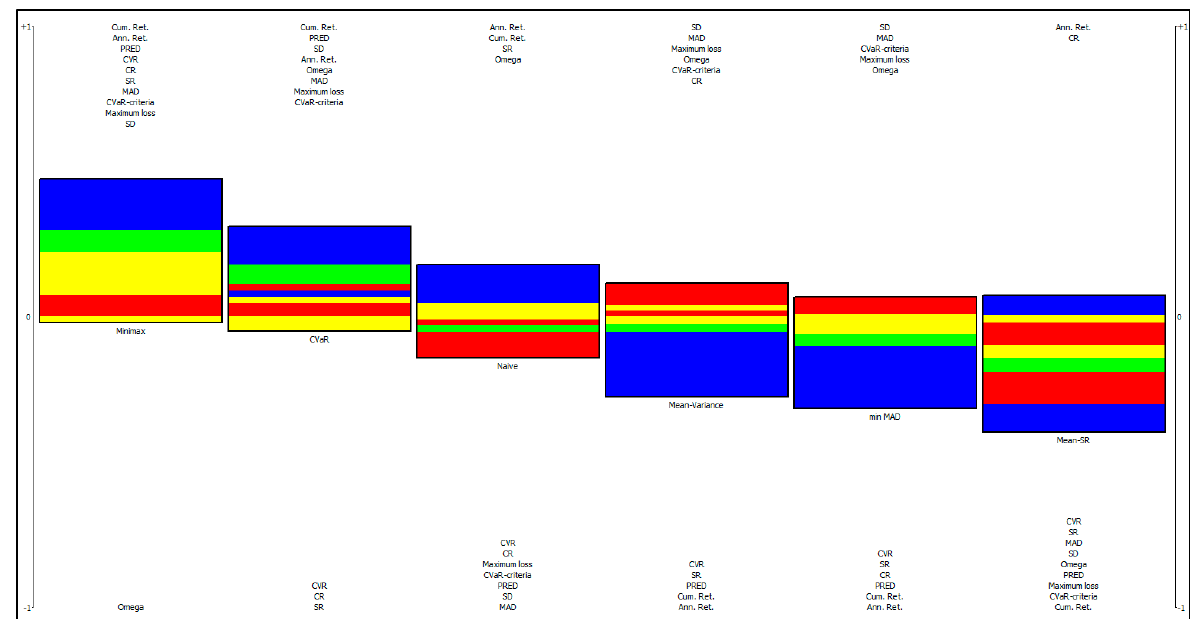
Figure 5. PROMETHEE Rainbow Diagram.